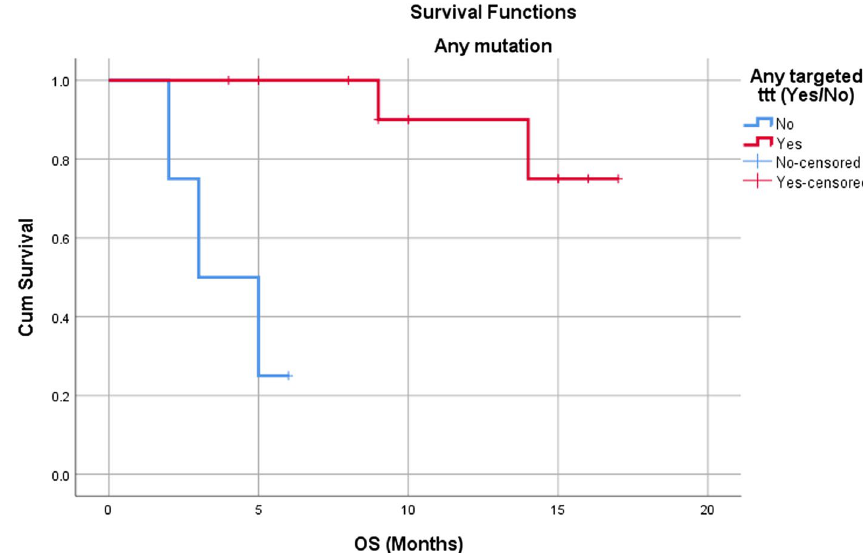
Fig. 2 Kaplan Meier plot of OS among mutated NSCLC by targeted therapy